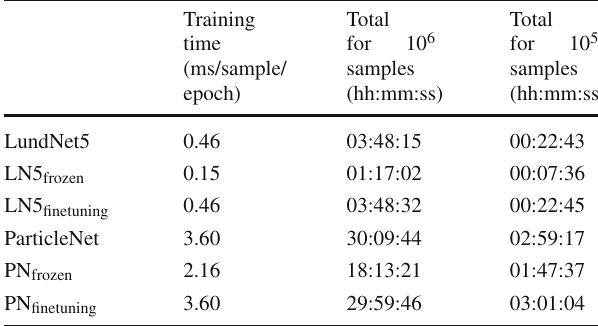
Table 1 Training time for different taggers. The time was measured when running the models on an NVIDIA GeForce RTX 2080 Ti card. Note that LundNet5 transferred from a top tagger with p T > 2 TeV, when trained on a data set 10 times smaller, still performs better than ParticleNet in terms of AUC (see Table 2) despite the time of training being significantly